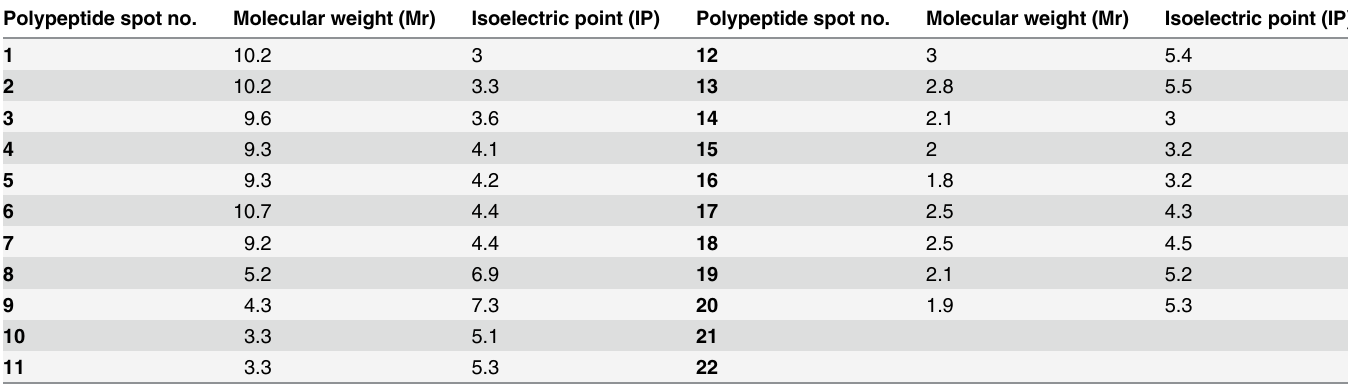
Table 2. T . gondii strain RH tachyzoite proteins (Fig. 6). Polypeptide spot no.